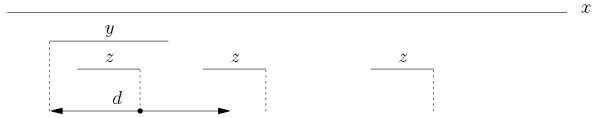
Basic head-to-tail index. Assuming there are no other occurrences of y and z in x, for a given distance d it is IHT (y, z) = 1.